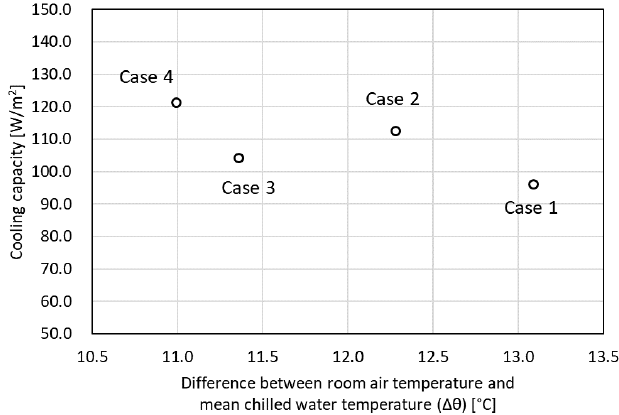
Figure 7. Relationship between Δθ and cooling capacity.